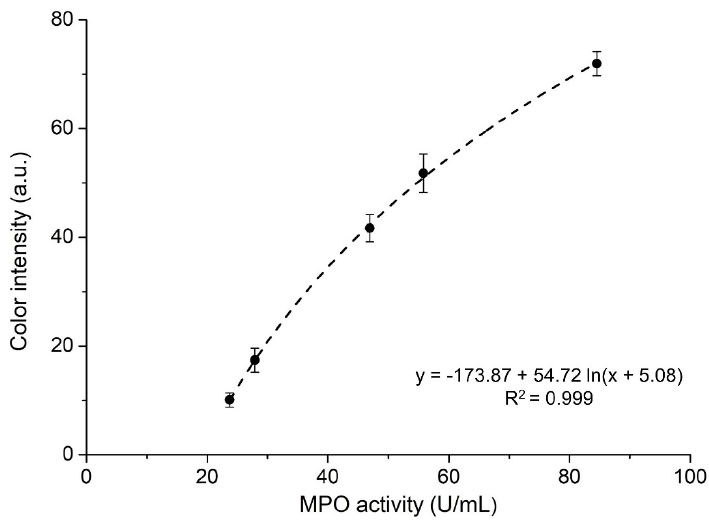
Figure 4. Color intensity of COR zone vs. MPO activity in the standard solutions quantified using spectrophotometry (N = 5).